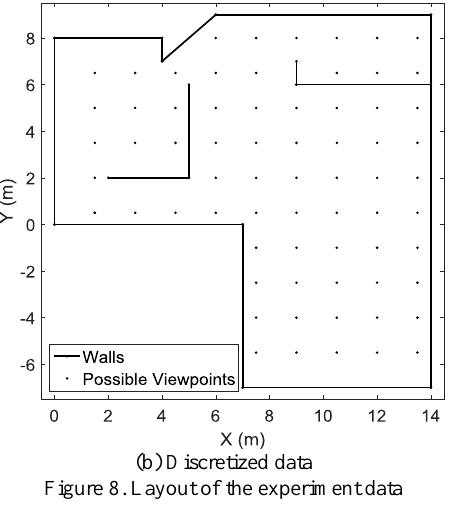
Pseudocode: Table 3 shows the pseudocode of the